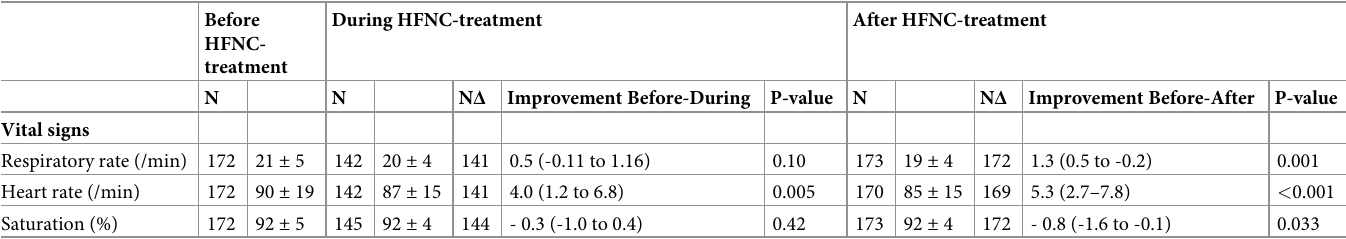
Values shown are mean and standard deviation. For Δ -values ( Δ Before-During and Δ Before-After) the mean change and 95% confidence interval for the means are shown. A paired T-test was used for comparison between values before and during and before and after.